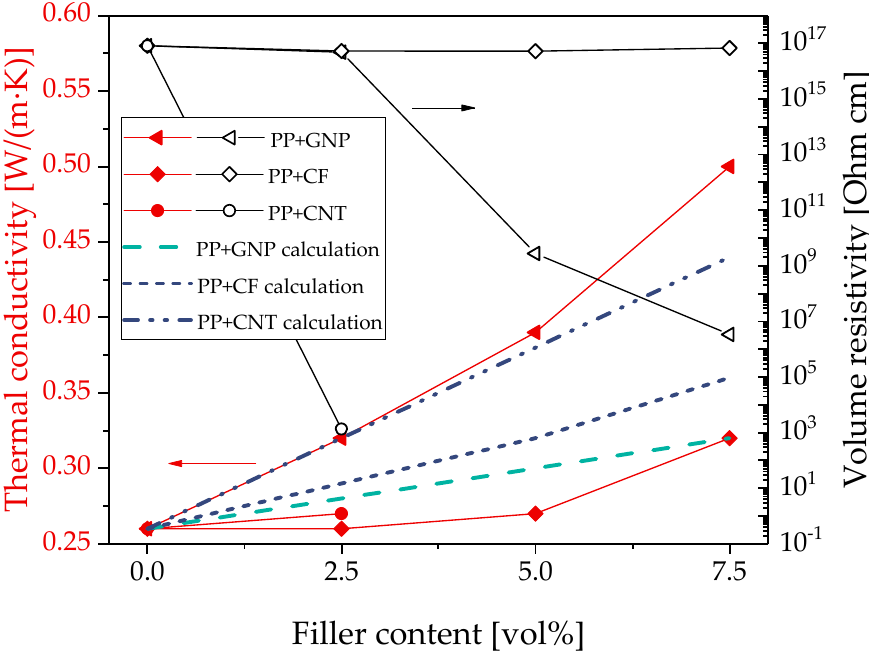
Figure 3. Thermal conductivity and electrical volume resistivity of PP filled with graphite nanoplates, carbon nanotubes, and carbon fibers, calculated values of PP / GNP (graphite nanoplatelets) using the Hatta model (green line) [48] and of PP / CF (carbon fibers) and PP / CNT (carbon nanotubes) using the Xue model (blue lines) [50].